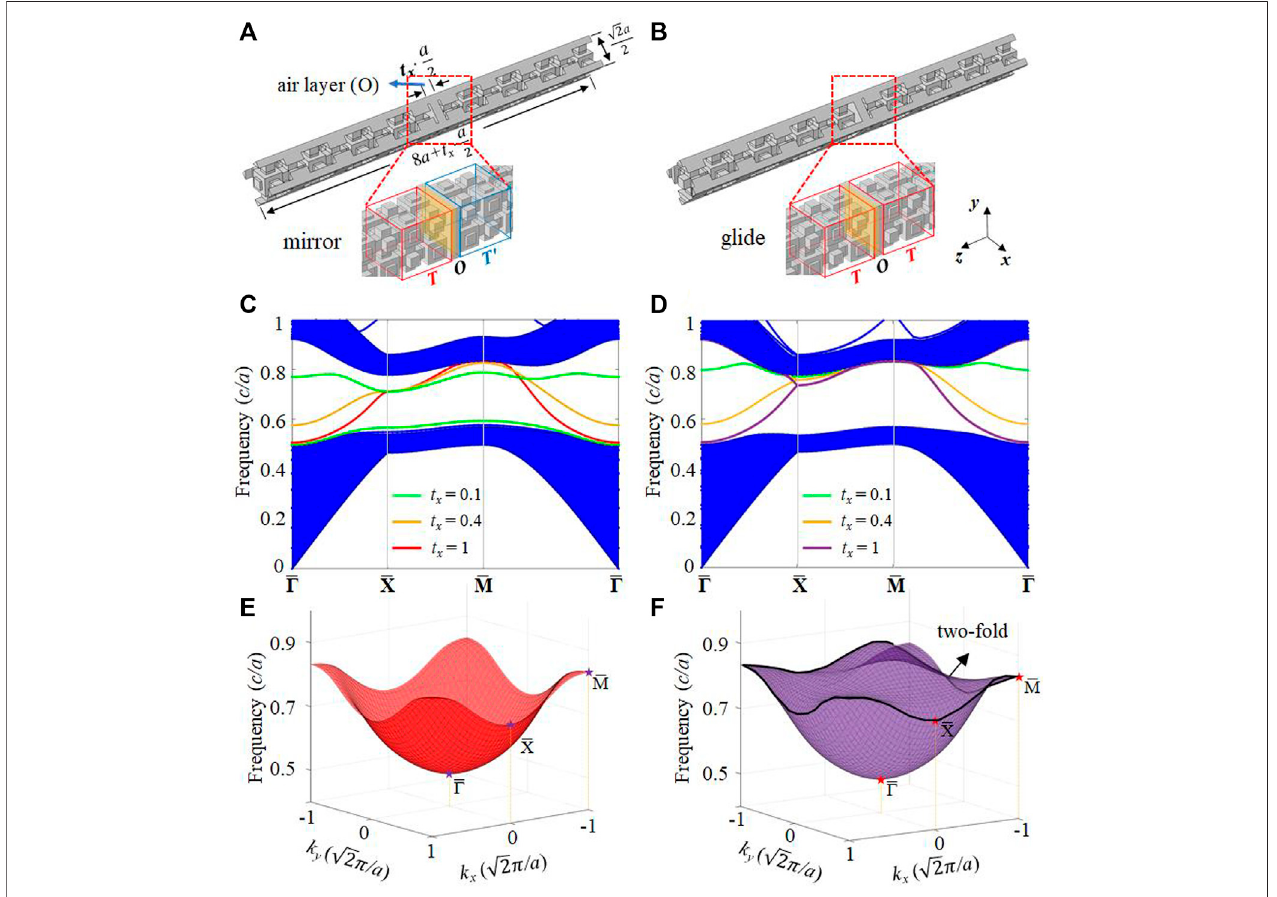
FIGURE4| Tunablesurfacesstates ondifferentsymmetries ofdomain walls. (A) Mirror-symmetry domain wallwitha t x a /2-thicknessairlayerat theinterface (T-O- T ’ con fi guration). (B) Glide-symmetry case (T-O-T con fi guration). (C-D) Projected band structures under various thicknesses of air layers corresponding to (A – B) . The green, orange, and red lines represent t x (cid:1) 0.1, 0.4, and 1, respectively (E-F) 3D views of surface states in (C – D) when t x (cid:1) 1.